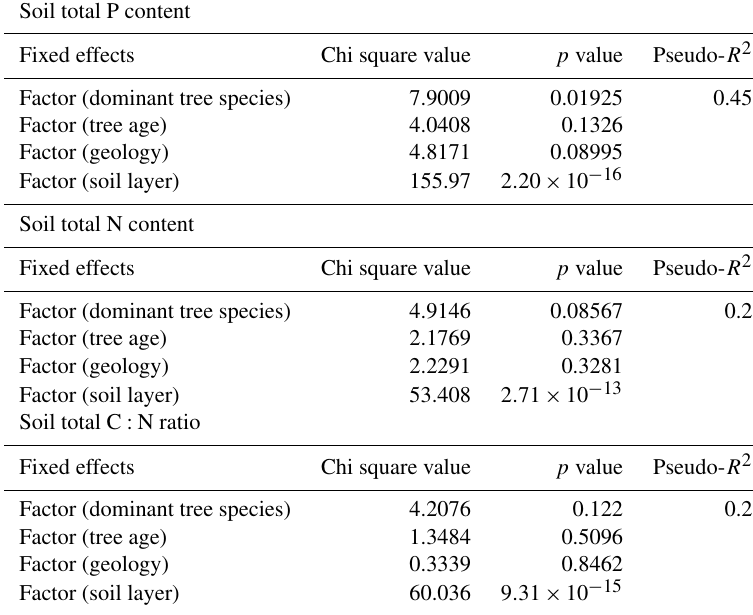
Table C3. Results from the mixed-effect models, testing the effects of environmental variables on soil total P and N content and C : N ratio. The tested variables were dominant tree species of the re- search plot, estimated tree age, rock parent material (geology) and soil layer. Random effect was related to plot number. Pseudo- R 2 was calculated based on Nakagawa and Schielzeth (2013), John- son (2014), and Jaeger et al.